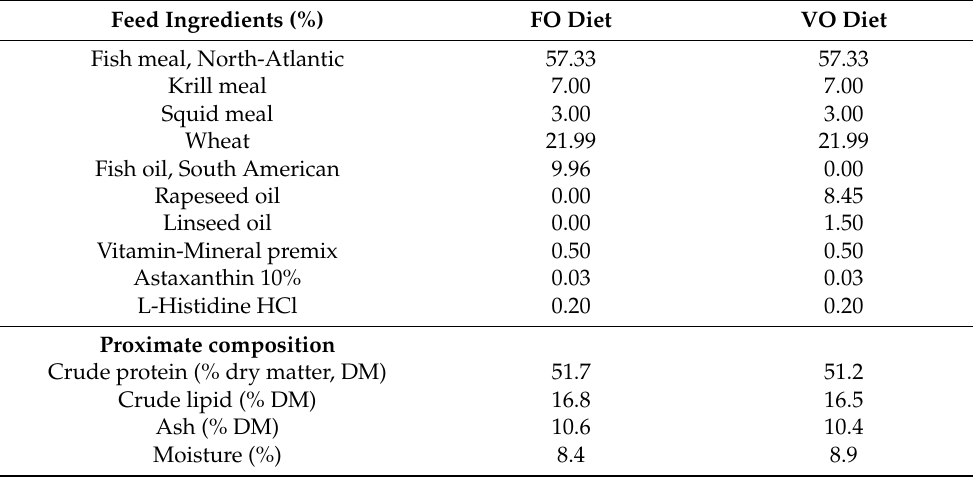
Table 2. Ingredients and proximate composition of the broodstock experimental diets used for mass spawning study.